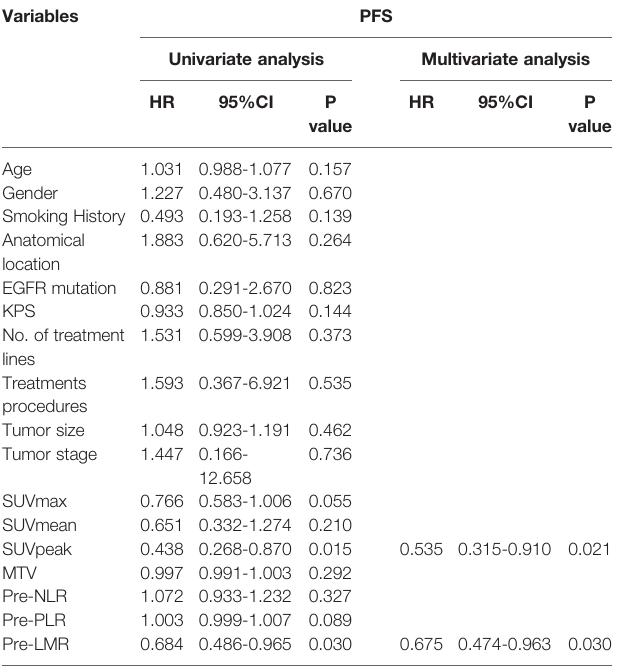
TABLE 4 | Univariate and multivariate progression-free survival analyses for patients with advanced NSCLC. Variables PFS Univariate